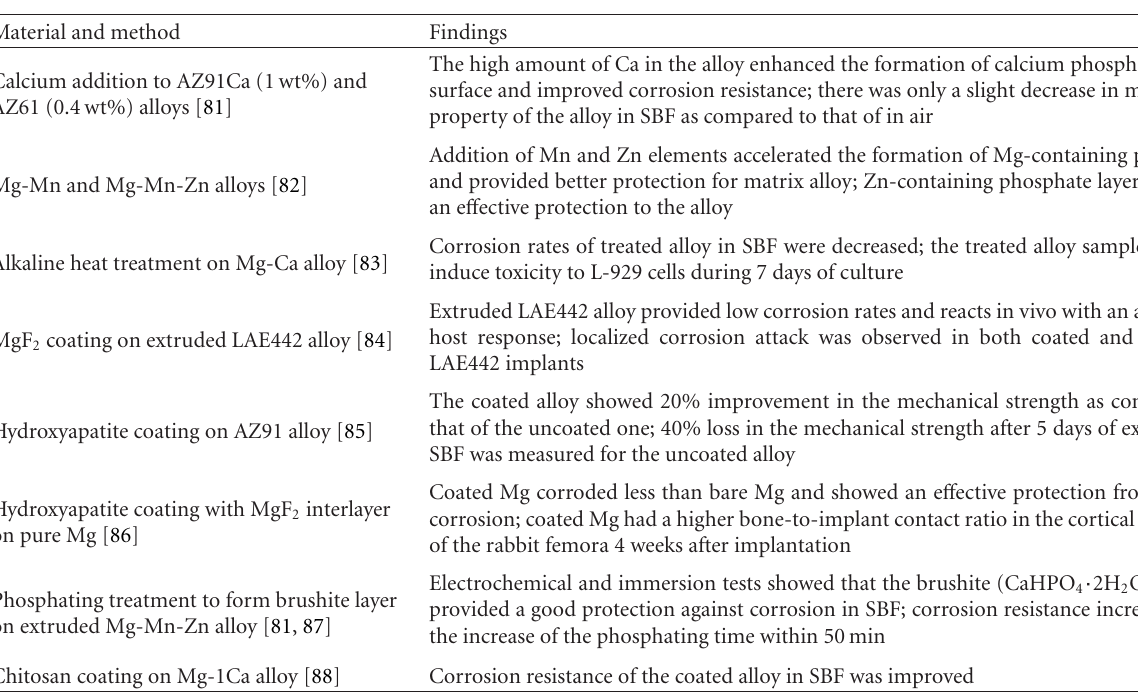
Table 2: Reports on corrosion resistance of Mg and its